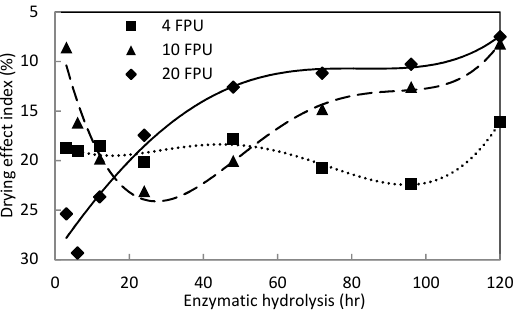
ff ect index depending on enzyme dosage and hydrolysis Figure 2. Drying effect index depending on enzyme dosage and hydrolysis time. Figure 2. Drying e